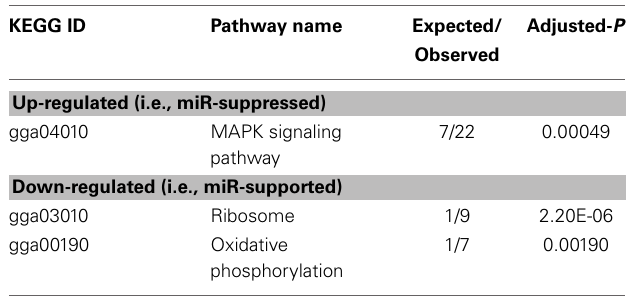
Table 4 | Enrichment of KEGG pathways in up- and down-regulated gene sets (following miR-2954